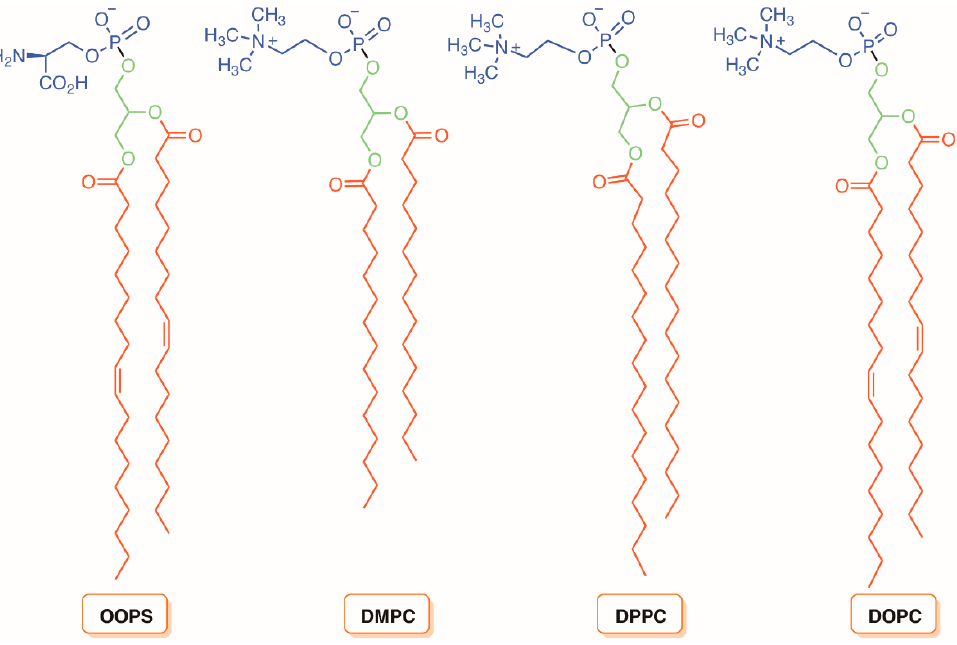
Figure 32. Structure of 5-(1-dodecanoylpyridinium-4yl]-10,15,20-triphenylporphyrin (TDPyP) and the cationic deliver systems DOTAP and SC 6 NH 2 (adapted from Reference [160]).